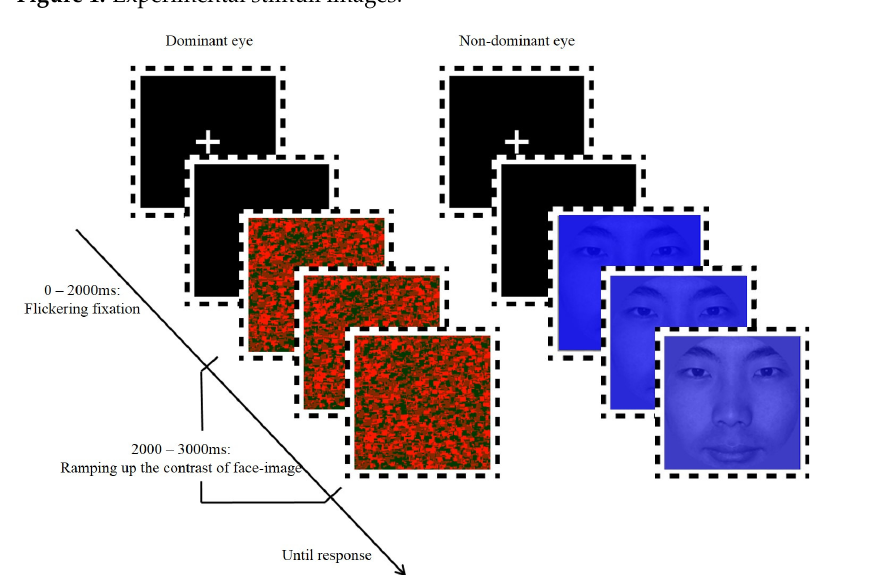
Figure 2. Illustration of a trial in the experimental